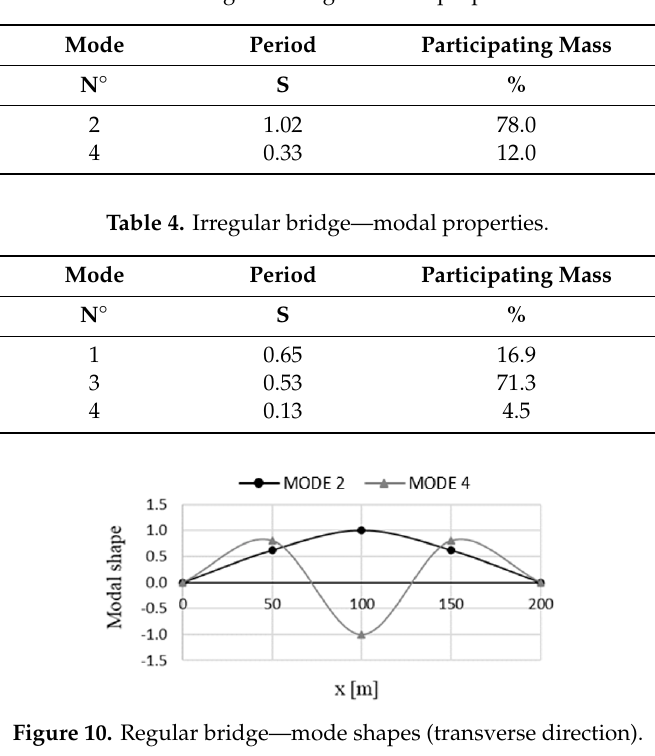
Figure 11. Irregular bridge—mode shapes (transverse direction).